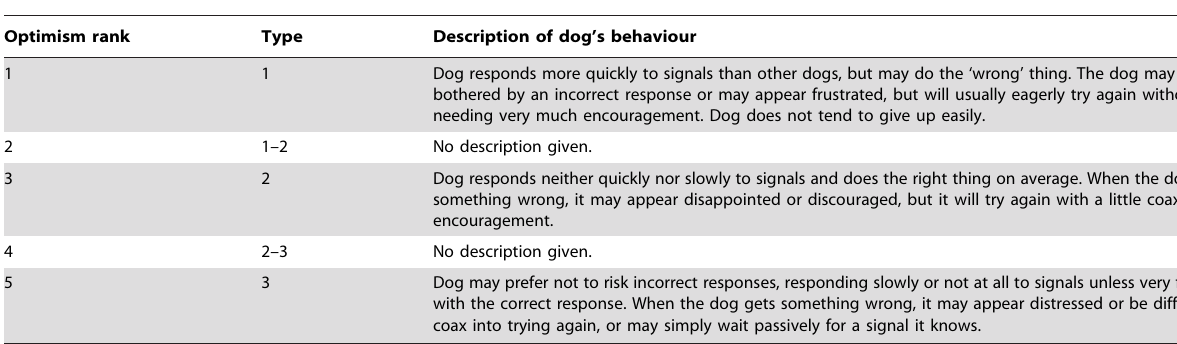
Table 5. Subjective descriptions of the behaviour of dogs during training and